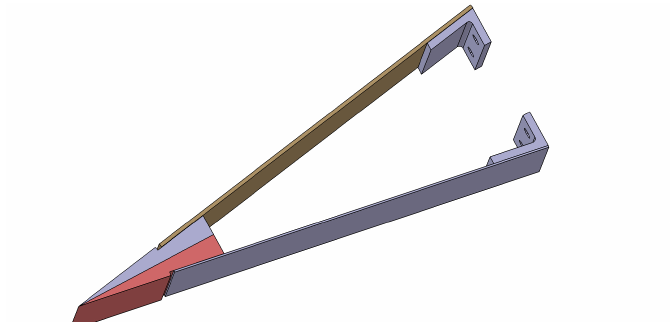
Figure 1. High-Bandwidth Morphing Actuator (HMBA).